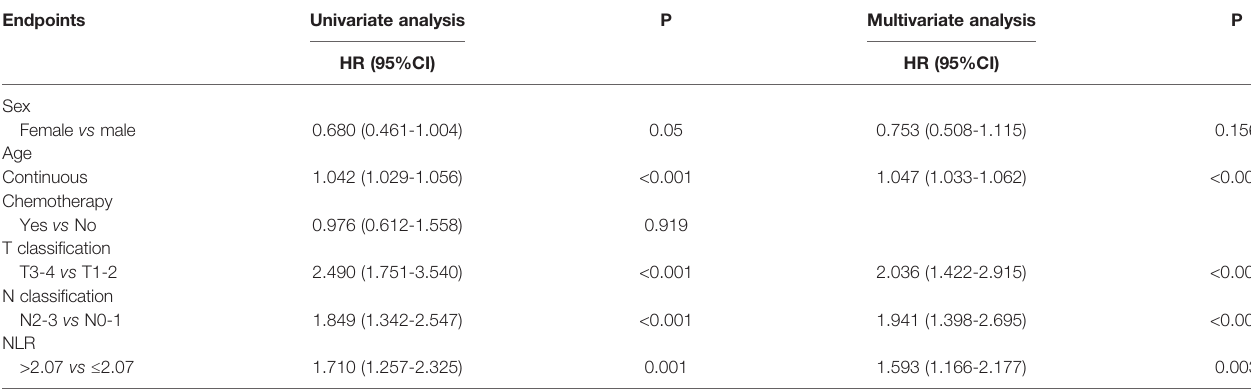
TABLE 2 | Univariate and multivariate analyses for the overall survival using Cox regression